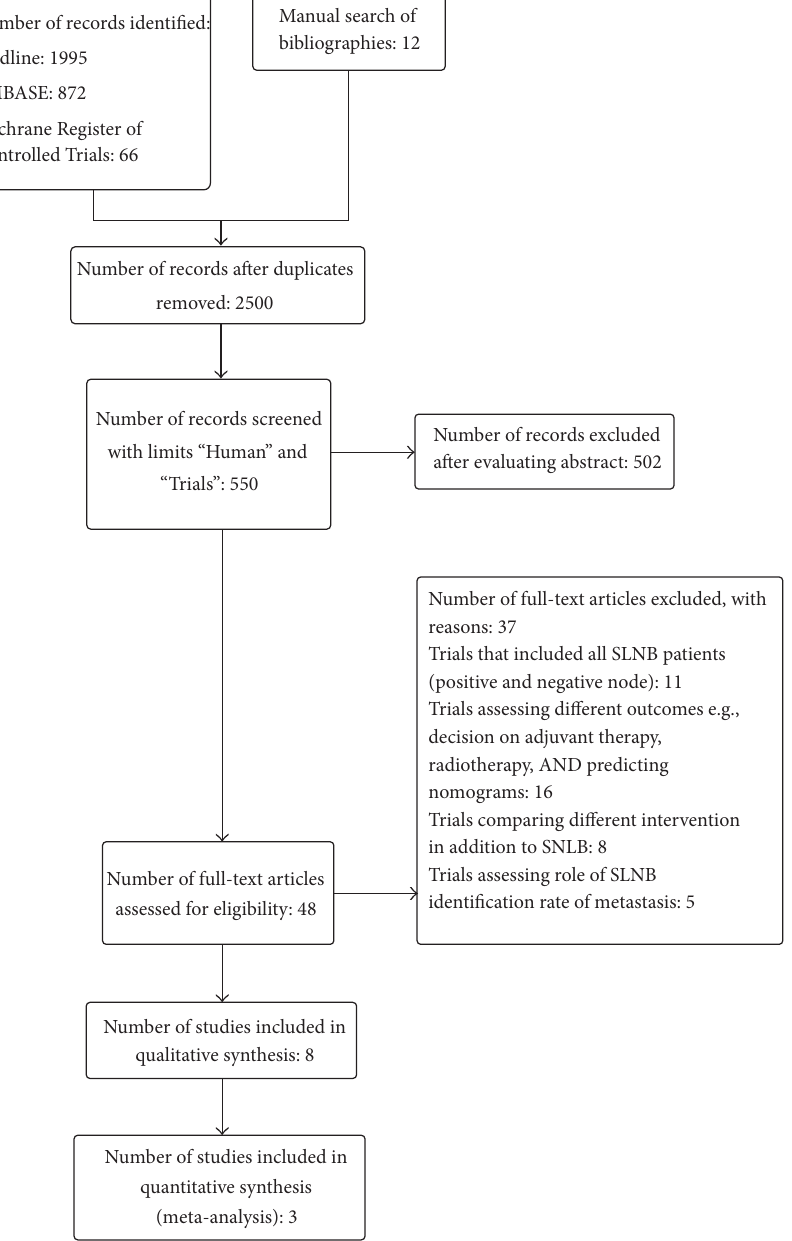
Figure 1: Flow diagram according to PRISMA statement